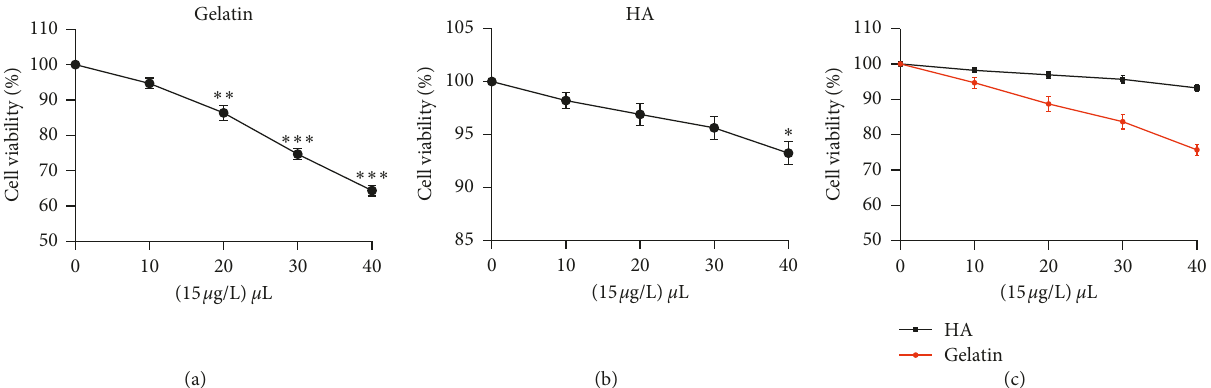
Figure 1: Nanoparticle detection and vector screening. (a, b) H125 cells proliferation activity. ∗ P < 0 . 05, ∗∗ P < 0 . 01, and ∗∗∗ P < 0 . 001 vs the 0 μ L group.